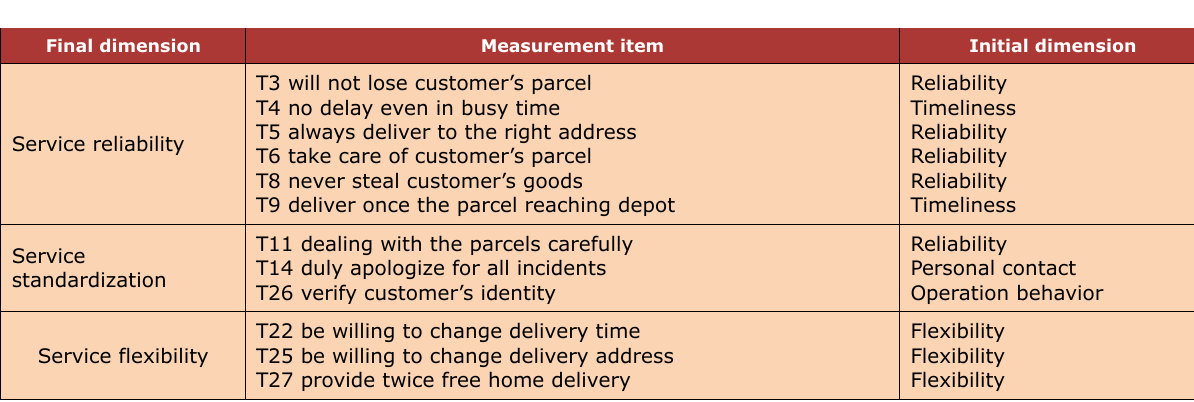
Table 3. Common factors and measurement items